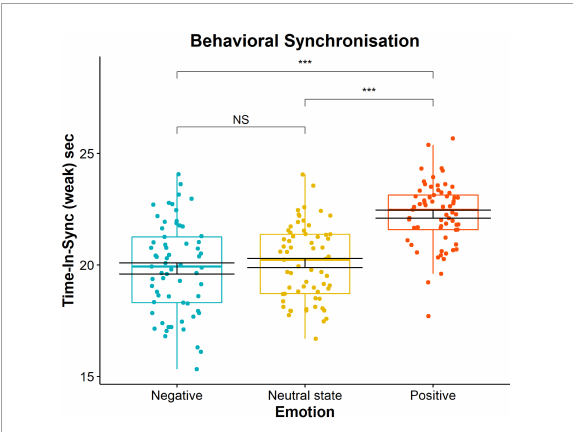
FIGURE6 Time in synchrony (s) pairwise comparison for each of the three emotional conditions (negative emotion, neutral state, and positive emotions). Each dot represents a score of one 30 s trial. Significance levels 0.001, 0.01, or 0.05 are indicated with *, **, and *,